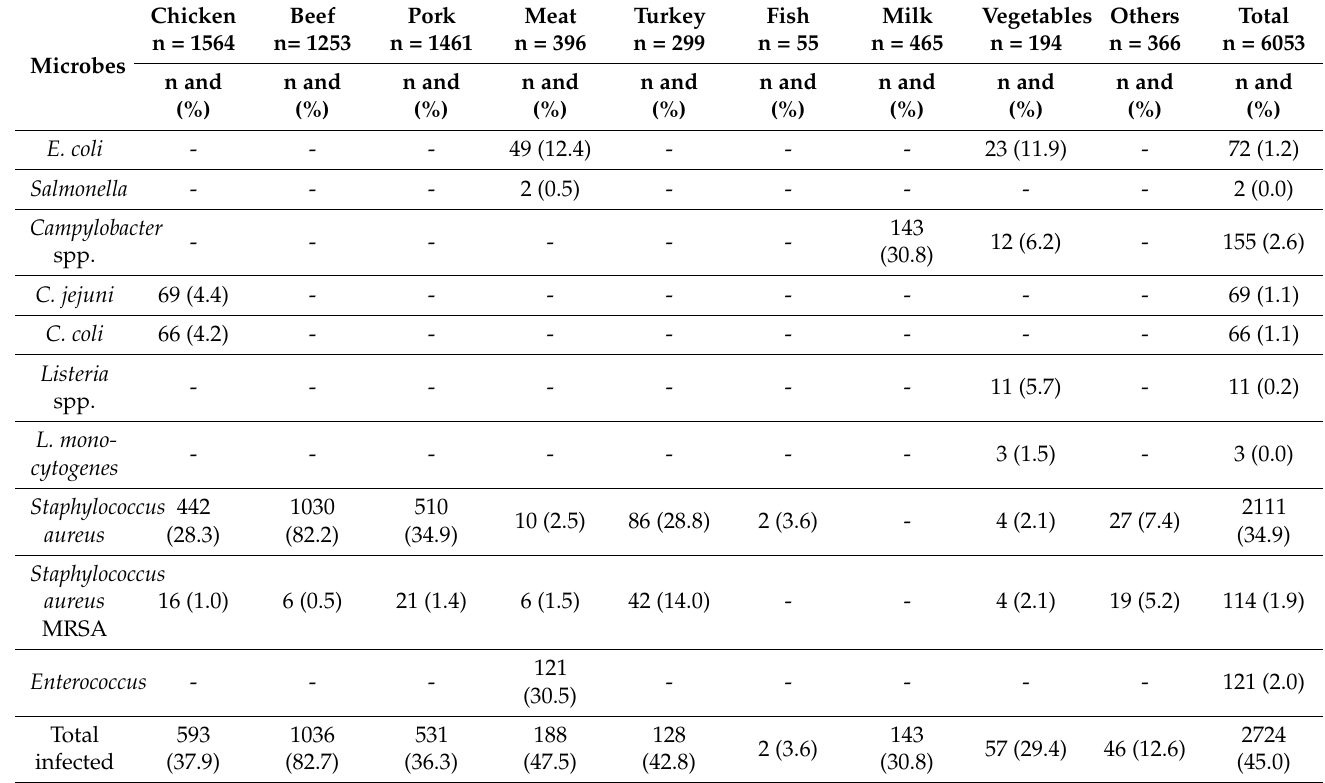
Table 2. Food product categories along with microbes that have been detected in USA from 2012 to 2021, where n = total number of food samples contaminated; % of